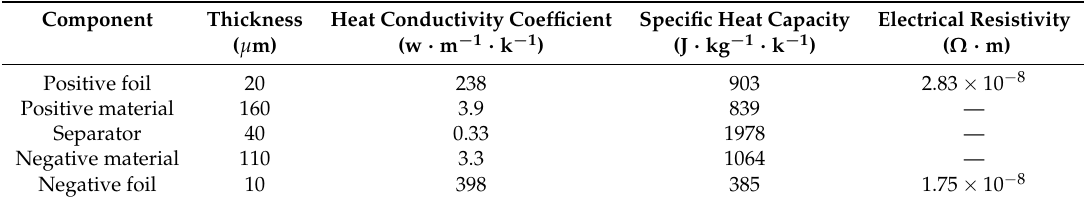
Table 1. Properties of each battery component.